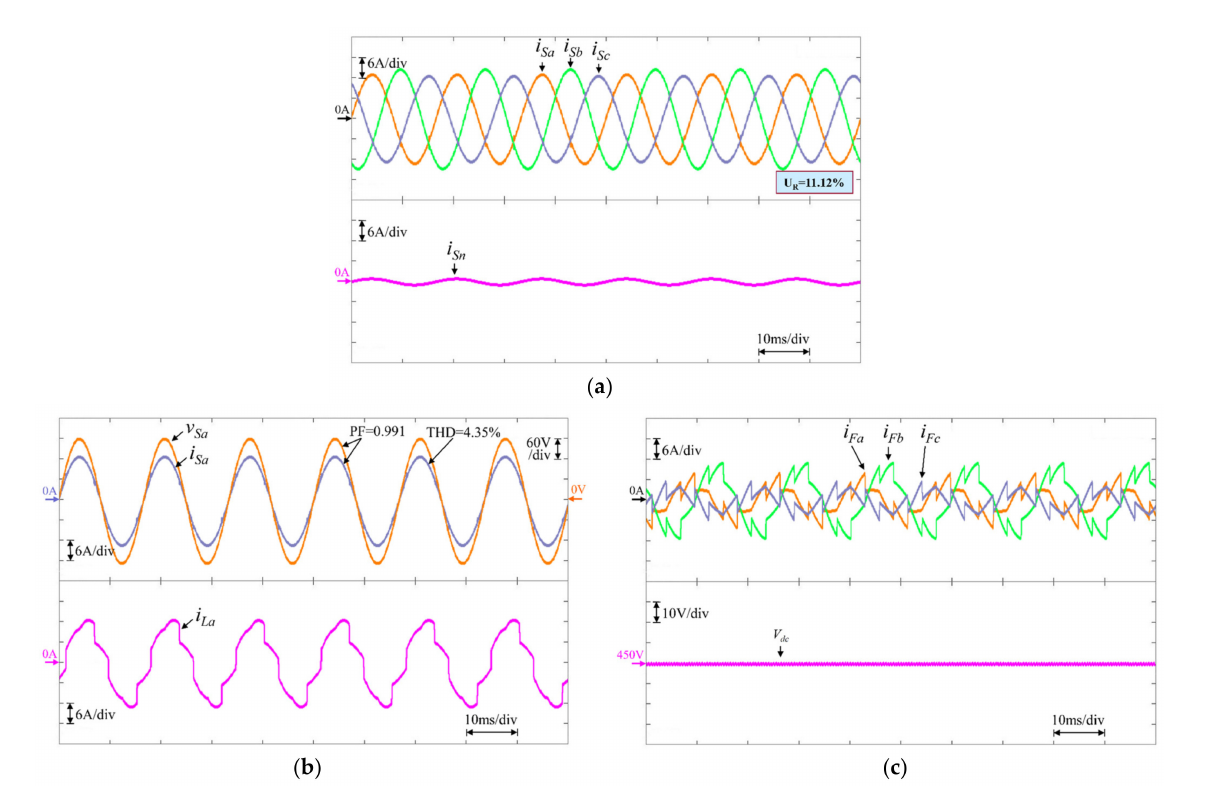
Figure 6. Experimental results using PI-controlled DSTATCOM at RL2. ( a ) Response of grid currents and neural current; ( b ) Response of phase- a grid voltage, phase- a grid current, and phase- a load current; and ( c ) Response of compensation currents and DC-link voltage of DSTATCOM.